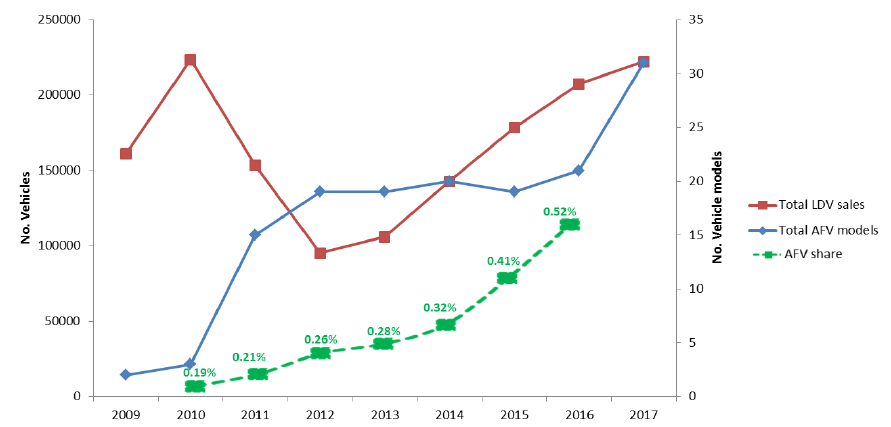
Figure 8. Evolution of Light Duty Vehicles (LDVs) sales with AFVs models introduction and the achieved AFVs share.